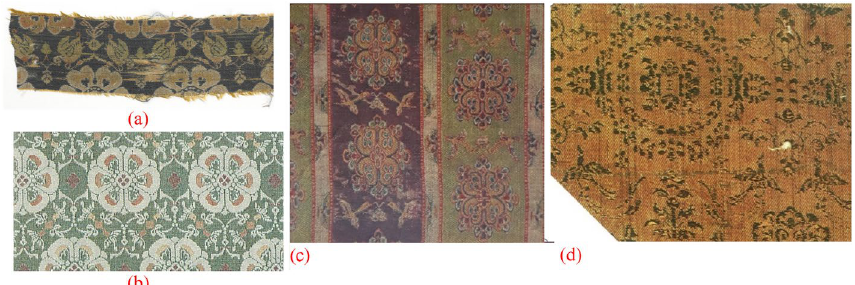
Fig. 2 Similarity of the patterns of birds, flowers and beads of two KyungGeum and two WiGeum. a Dark background KyungGeum from Astana ( 阿斯塔那 ) (Kim et al., 2021). b Green KyungGeum from Kyoto Nishijin ( 京都 西 陣 ) of Japan (styles of Korean Geum 韓錦 ) (Baik & Choi, 2014). c WiGeum of elaborate stripes, 2 birds and flowers in the armrest pillow cover (70 x 20.5 x 15cm 長 班 錦 御軾 ) of the king, Shosoin, Japan (Treasure of Imperial, 1999) (https:// shoso in‑ ten. jp/ artic les/ detail/ 000038. html). d WiGeum with the pattern design of 2 large birds and 4 types of flowers mounted on Todaiji ( 東 大 寺 ) screen ( 花鳥浮文 錦 ), Shosoin, Japan (Treasure of Imperial, 1999) (by the courtesy permission of The Imperial Household Agency of Japan) (All photos are with permission from the copyright